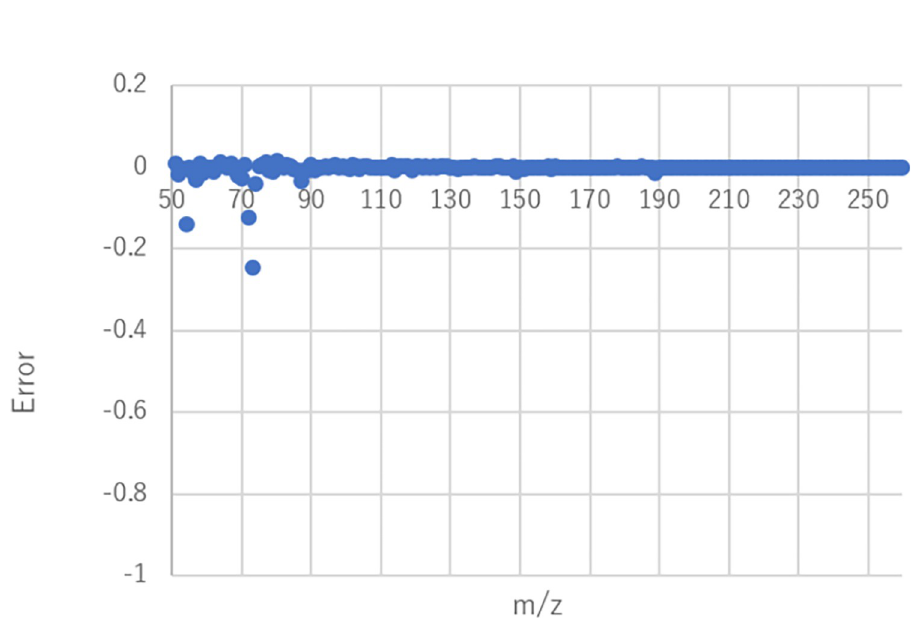
Fig 13. Error between obtained mass spectrum and approximated one using 2106 flavor molecules by nonnegative least square regression (‘sweet’).